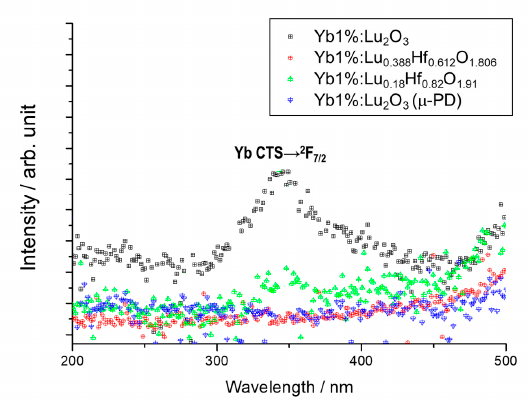
Figure 8. Radioluminescence spectra excited by X-rays (Cu K α 30 mV, 110 μ A). CTS: charge transfer state. Table 1. ICP-MS results of the CH- and μ -PD-grown Yb1%-doped Lu 2 O 3 on Cu, Re, Ir, and W ions.